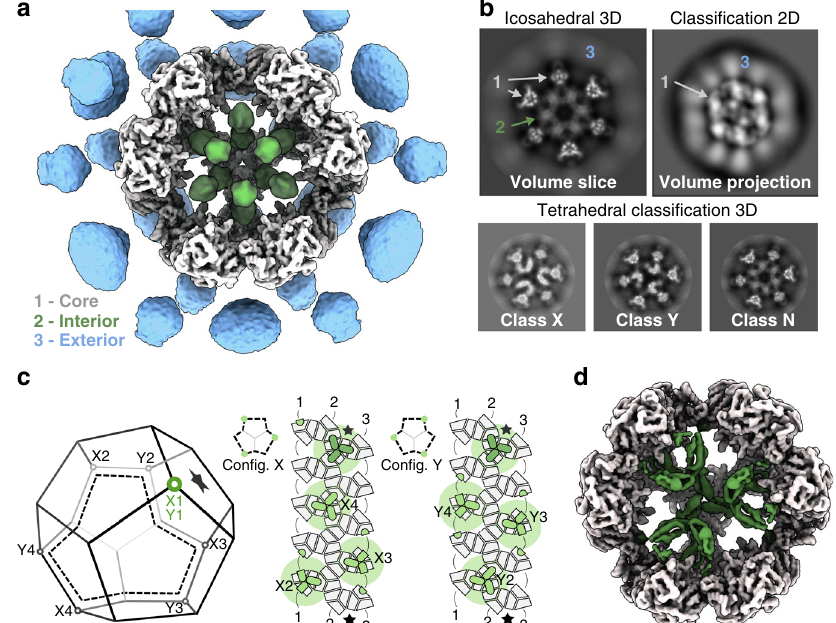
Fig. 1 The N. crassa PDC has a core-internal protein with tetrahedral optimal packing. a Reconstruction of the intact native PDC imposing icosahedral symmetry shows symmetrization artifacts, both exterior (blue) and interior (green) to the core (gray), predominantly along fi vefold (interior and exterior) and twofold (exterior) symmetry axes. b Whereas the exterior artifact appears to represent a continuous degree of freedom resulting in a blurred but elevated density, the interior component is consistent with a discrete mixture of states. Classi fi cation of the PDC as tetrahedral resolves this mixture into three classes of interest: tetrahedral classes X and Y, and class N that still appears to be over-symmetrized. c A schematic dodecahedron (left) illustrates which four E2 trimers (vertices) are occupied by interior density in each of classes X and Y. These arrangements are also shown mapped to an unfolded view of the E2 core (right), where each E2 monomer is shown in gray, and each interior monomer is shown in green. These monomers form four threefold- symmetric oligomers with equivalent positioning (also Supplementary Fig. 1). The effective volumetric occlusion of the core interior is schematically illustrated by a background circle — two interior components cannot be placed closer than shown here. d A cutaway view illustrates the tetrahedral class Y reconstruction, and the protein-like density (green) interior to the PDC